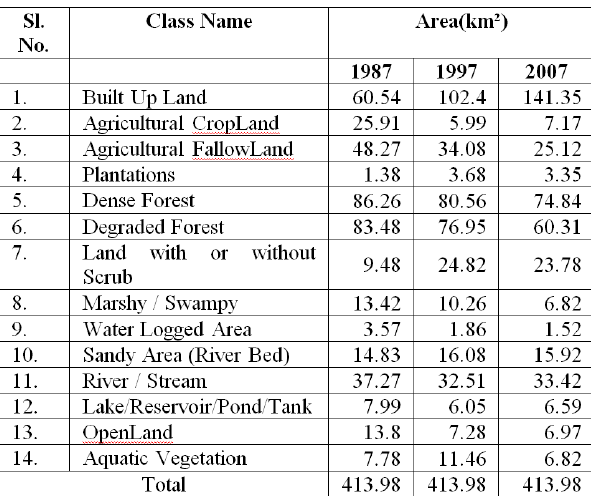
Table 2: Area statistics of LULC (land use land cover)